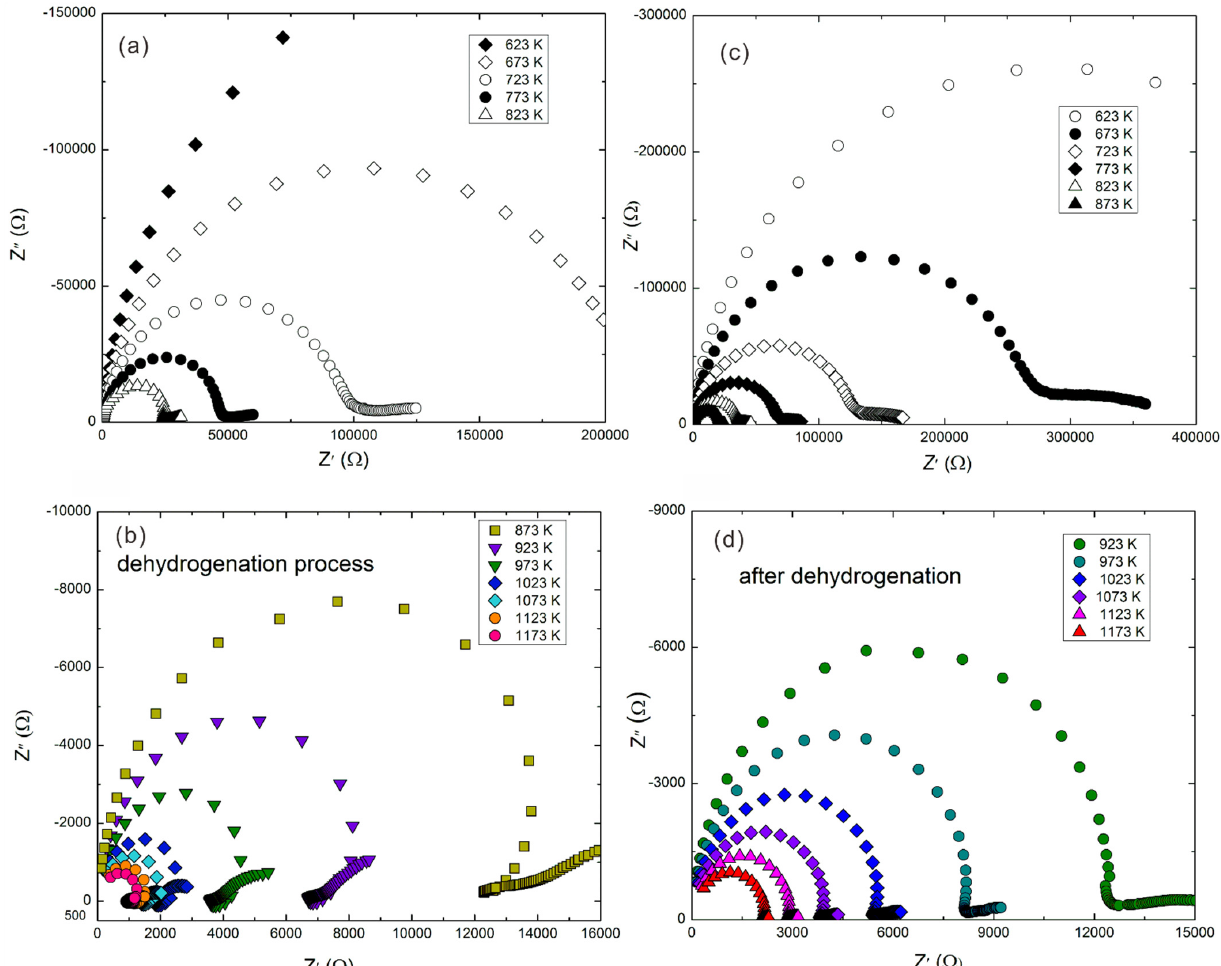
Figure 4. Representative complex impedance spectra for natural hydrous Fe-bearing amphibole single crystals from Sichuan province of southwest China at conditions of 1.0 GPa, 623–1173 K and the frequency ranges from 10 − 1 to 10 6 Hz. Here, ( a , b ) represent complex impedance spectra during the 1st heating cycle before the dehydrogenation process, respectively; ( c , d ) represent complex impedance spectra during the equivalent state of 3rd cooling cycle after the oxidation − dehydrogenation reaction, respectively. It is clear that the variation of impedance semi-circular arc from the inductive loop to normally “standardized” small tail within the low frequency regime of ~10 − 1 − 10 3 Hz at the critical temperature of ~873 K reveals the occurrence of an oxidation − dehydrogenation reaction. The equivalent circuit composed of two individually parallel resistance and constant phase element in the series connection was chosen to fit these impedance arcs for ( a , c , d ), respectively; the equivalent circuit composed of two individually parallel resistance and inductive reactance in the series connection was chosen to fit these impedance arcs for ( b ) (reproduced with permission from the reference of Hu et al. [34]; published by Elsevier,